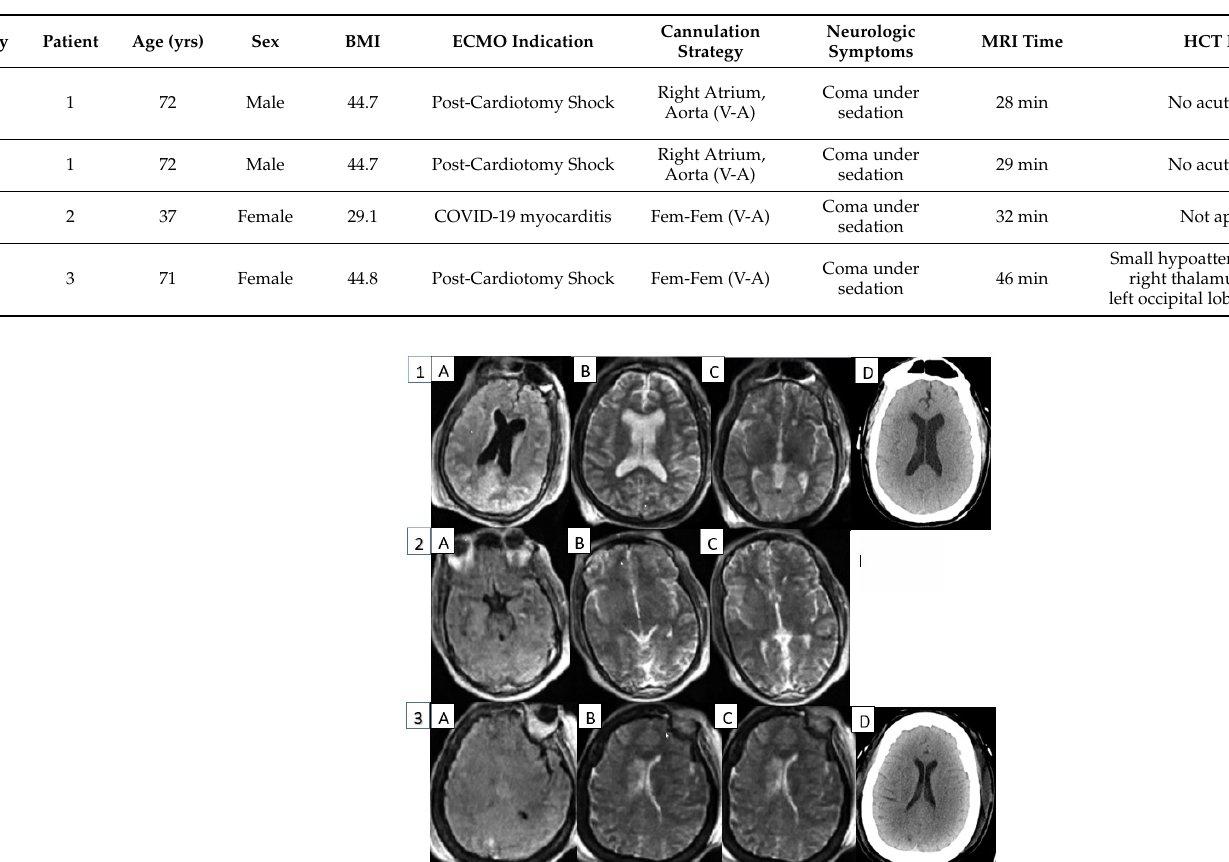
Table 1. Patient characteristics and adverse events during portable brain MRI scan.